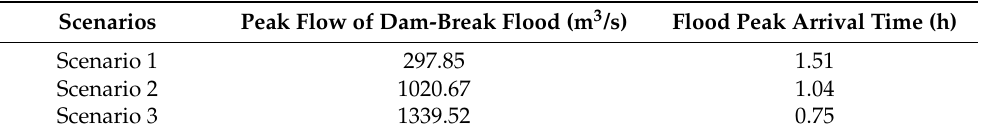
Table 5. Main simulation results of scenarios 1, 2, and 3.